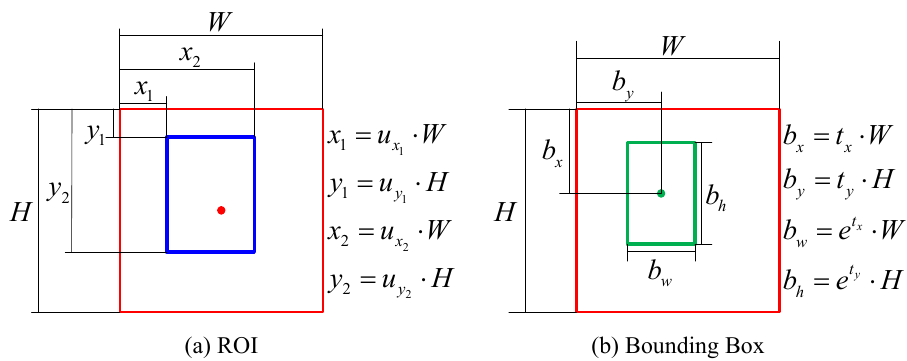
Figure 3. ROI and bounding box. The red point denotes the point of interest proposed by the baseline selector, and the red box indicates the selected region centered by the point of interest. Due to the error of the baseline selector, the point of interest cannot properly coincide with the center of the ground-truth bounding box. The blue box shows the ROI proposed by the discriminator. The green box denotes the predicted bounding box, and the green point represents the center of the predicted bounding